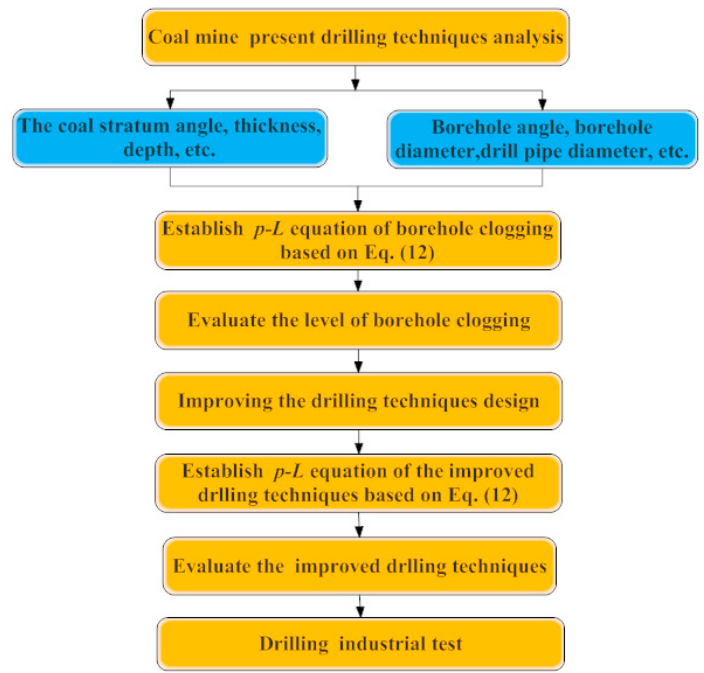
Figure 9. The flow diagram for the mechanical model of borehole clogging in the engineering application.